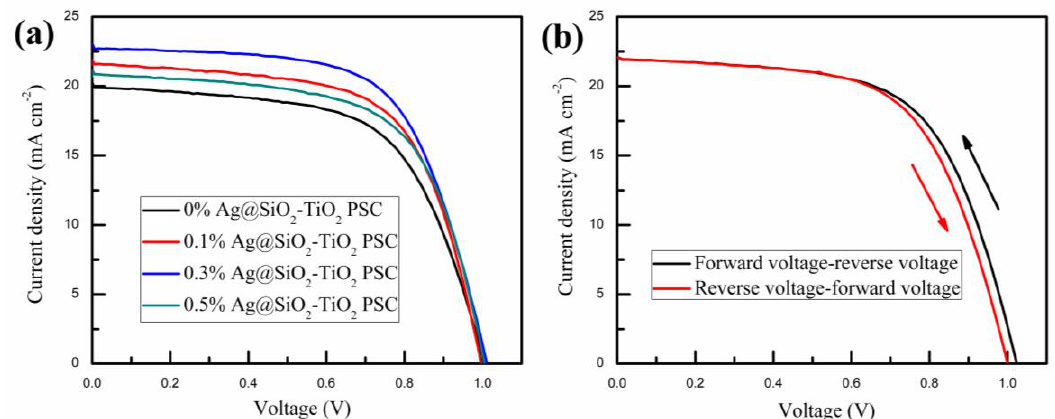
Figure 6. ( a ) J - V curves of PSC devices based on mesoporous TiO 2 film mixed with different amounts of Ag@SiO 2 NPs; ( b ) J - V curves scanned form forward voltage to reverse voltage and scanned form reverse voltage to forward voltage. Table 1. Summarized photovoltaic parameters of PSC devices based on mesoporous TiO 2 film mixed with different amounts of Ag@SiO 2 NPs. Table 2. Summarized photovoltaic parameters of PSC devices scanned form forward voltage to reverse voltage and scanned form reverse voltage to forward voltage.